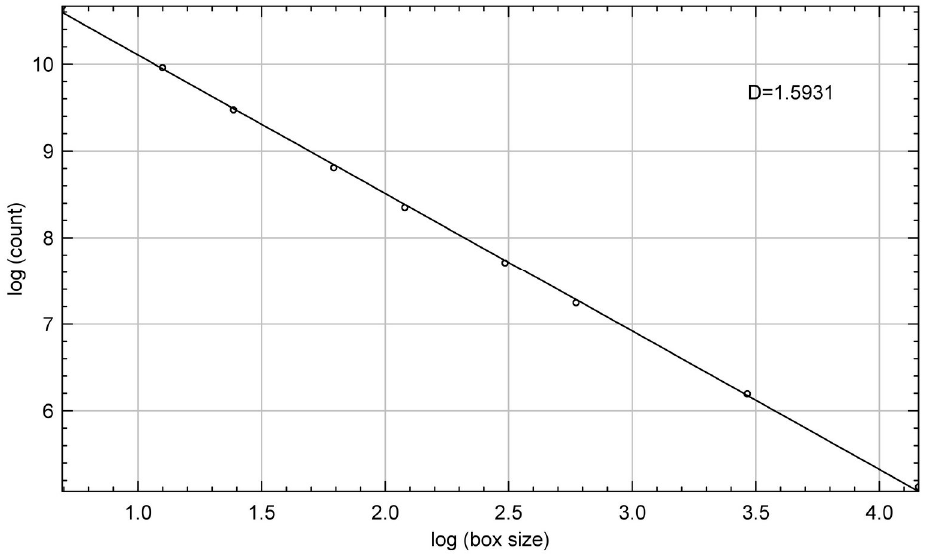
Figure 4. Fractal dimension of dendritic pattern simulated by 20,000 particles (as shown in Figure 3).